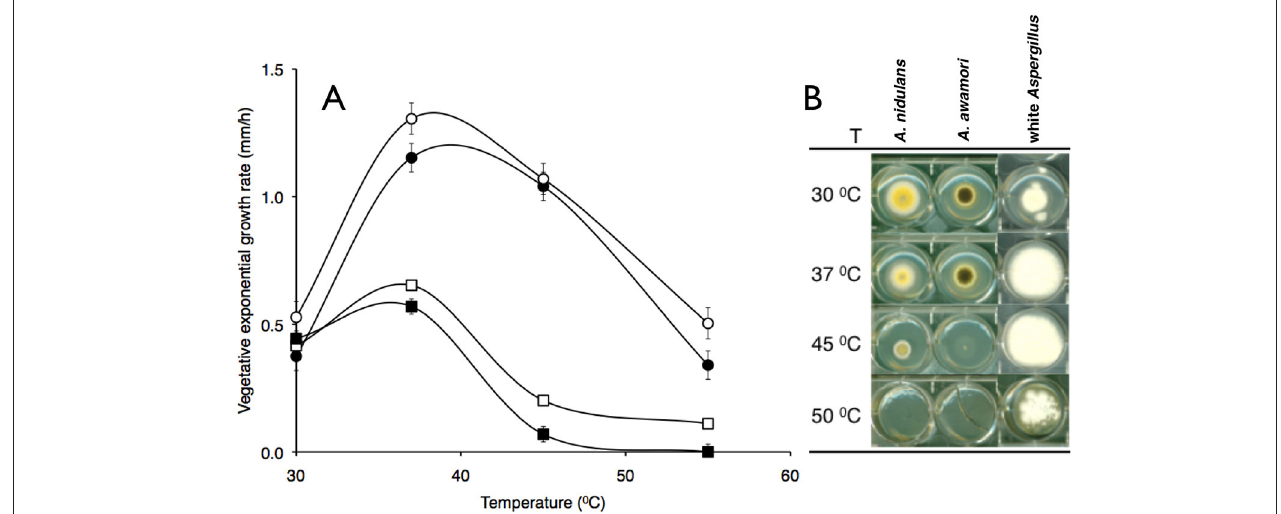
FIGURE 1 | Temperature-dependent vegetative exponential growth rate of aspergilla. Colonies of four aspergilli were single-colony inoculated onto complete medium and radial growth rates (mm/h) measured between the 22nd and 45th hour of continuous vegetative growth at indicated temperatures. (A) A. fumigatus Af293 and A. fumigatus var. niveus (open and closed circles), A. nidulans and A. awamori (open and closed squares) vegetative exponential growth rates (reported as millimeters per hour). (B) Vegetative colony morphology of aspergilli grown at various temperatures labeled as shown.